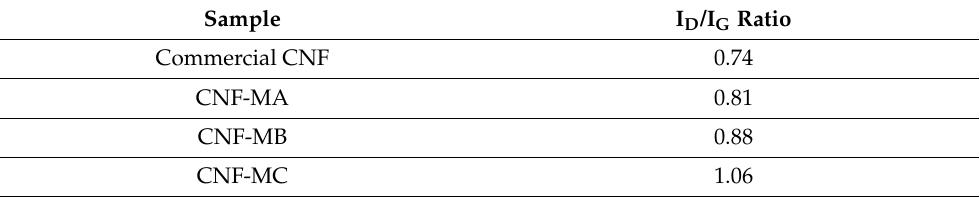
Table 4. The I D /I G ratio of the commercial CNF and surface-oxidised CNF samples.